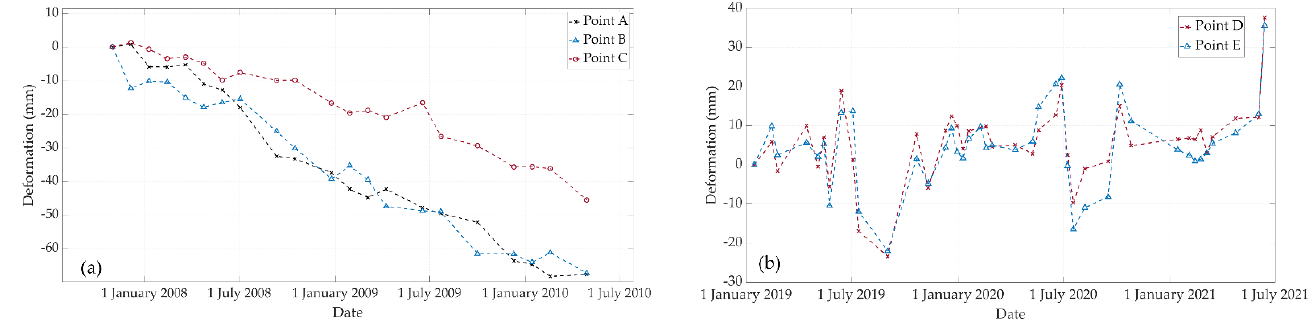
Figure 6. Time-series deformation information at the typical deformation area. ( a ) Obtained from Envisat T39 (Points A, B, and C are displayed in Figure 5a). ( b ) Obtained from Sentinel 1A (Point D and E are displayed in Figure 5b).